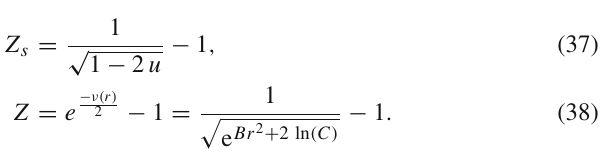
The surface redshift ( Z s ) and gravitational redshift ( Z ) are represented respectively